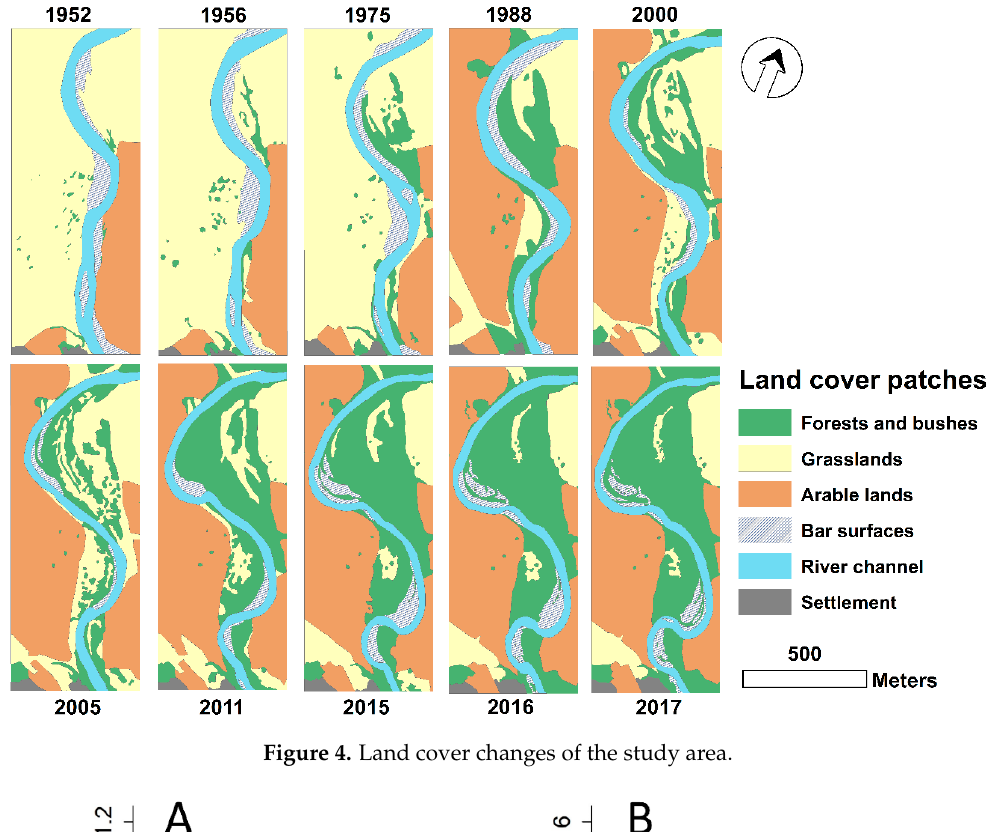
Figure 4. Land cover changes of the study area.